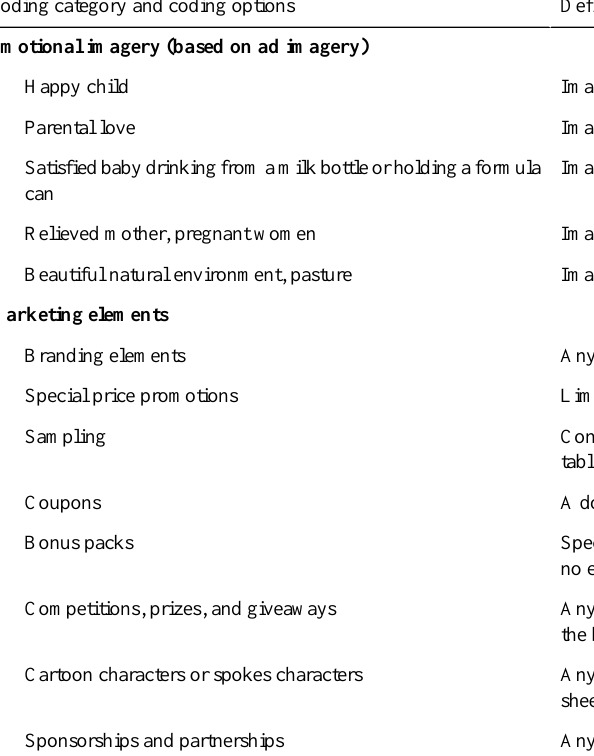
Definition or examplesCoding category and coding options